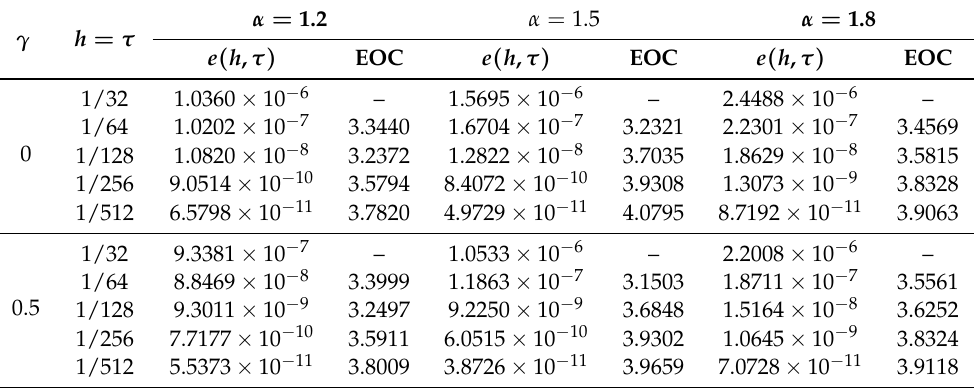
Table 1. The errors and EOCs of SAV-WSLD-Gauss2 method for Equation (18) at time T = 1 by keeping h = τ .